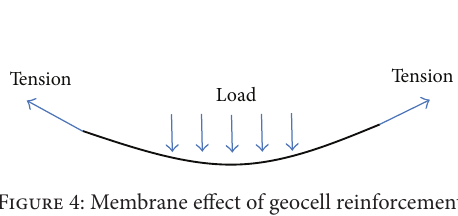
Figure 3: Vertical stress dispersion effect of geocell reinforcement.